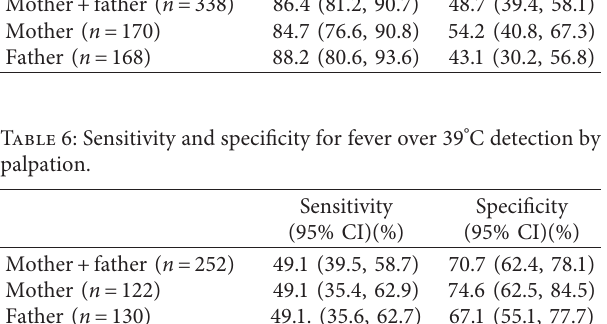
95% CI: 95% confidence interval; n : sample